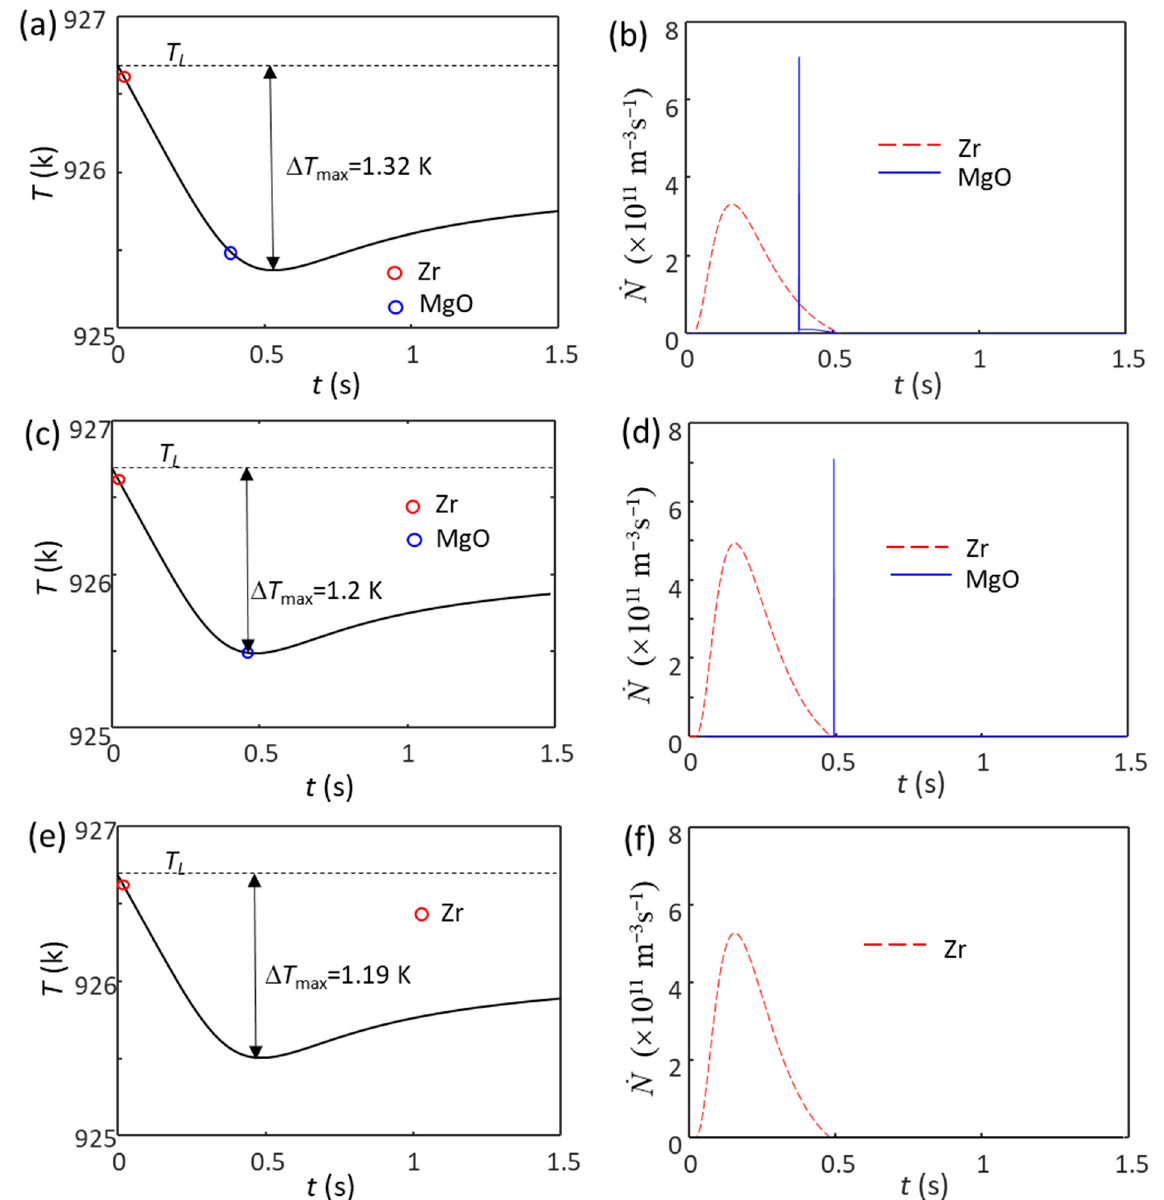
Figure 5. The calculated cooling curves ( a , c , e ) and grain initiation rates ( b , d , f ) of Mg-0.45Zr alloy with different amounts of Zr particles and without intensive melt shearing at a cooling rate of 3.5 K/s. ( a , b ) N 0 = 1 × 10 11 m − 3 , ( c , d ) N 0 = 1.5 × 10 11 m − 3 , ( e , f ) N 0 = 1.6 × 10 11 m − 3 . All the Zr particles are assumed to have the same log-normal size distribution ( d 0 = 0.73 µ m and σ = 0.62 (data from Ref. [62])). The red and blue circles mark the onset of grain initiation on solid particles induced by Zr and MgO particles,